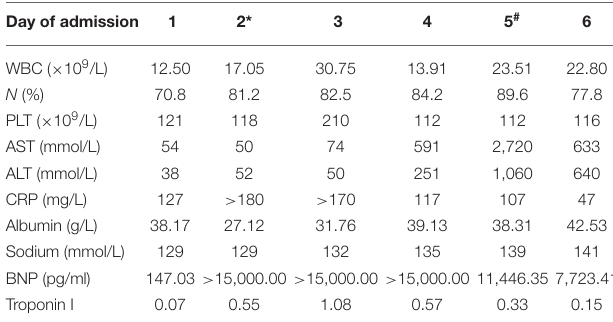
TABLE 1 | Laboratory findings pre- and